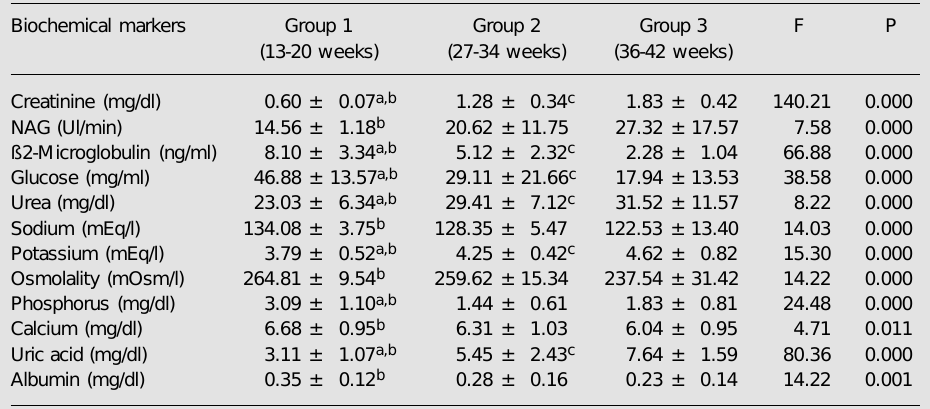
Table 1. Values of biochemical markers in amniotic fluid throughout gestation. Biochemical